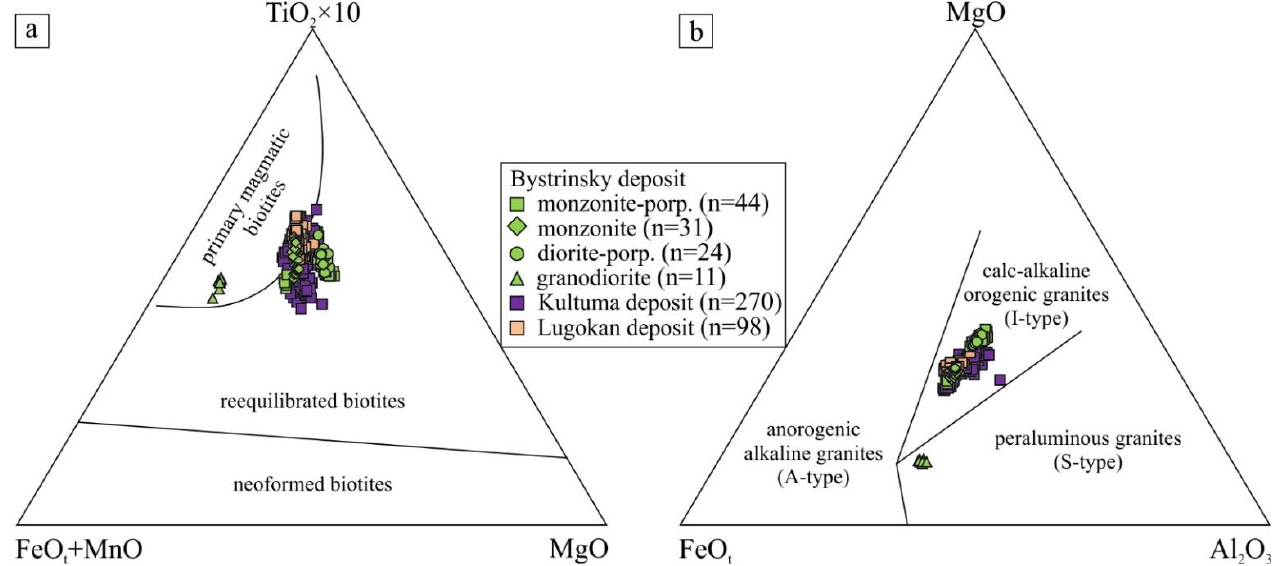
Figure 5. Chemical composition diagrams of biotite: ( a ) — ternary TiO 2 -(FeO t + MnO)-MgO diagram [16]; ( b ) — tectonic setting discrimination diagram based on FeO t -MgO-Al 2 O 3 [17].